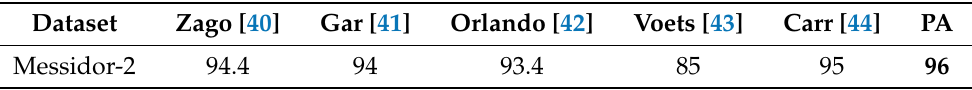
Table 5. Comparison of existing approaches with proposed approach (PA) in terms of % accuracy on the dataset, namely Messidor-2 using 10-fold cross